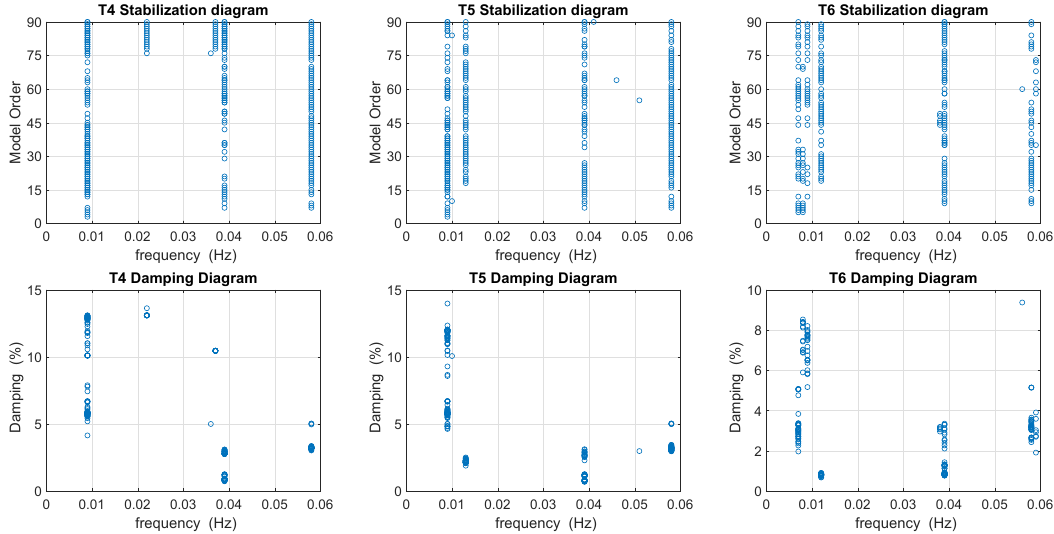
Figure 4. Stabilization and damping diagrams for Simulations T4, T5, and